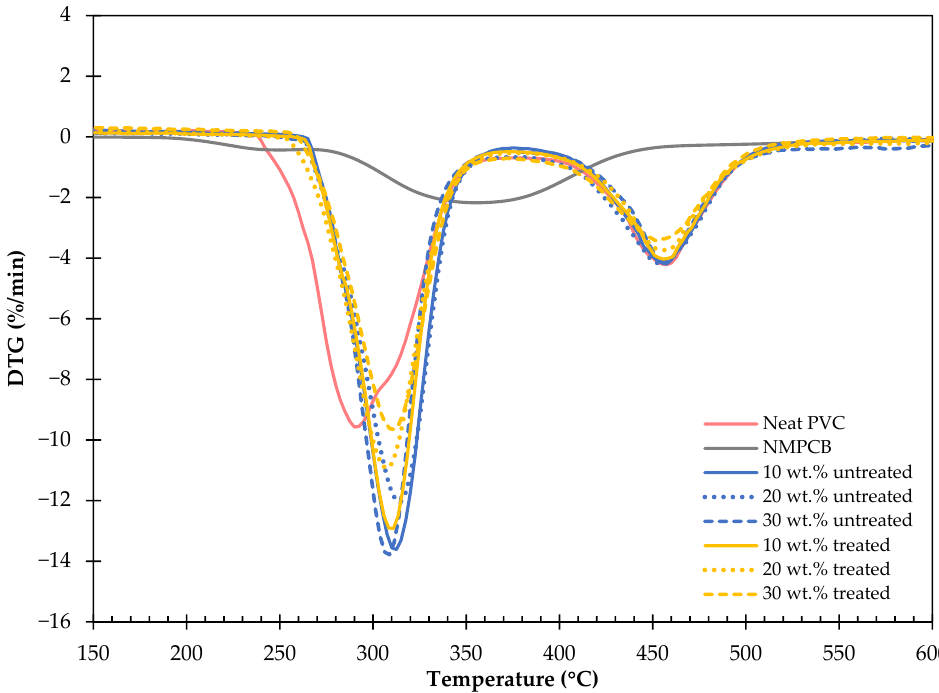
Figure 7. DTG of the untreated and treated NMPCB/PVC composites.